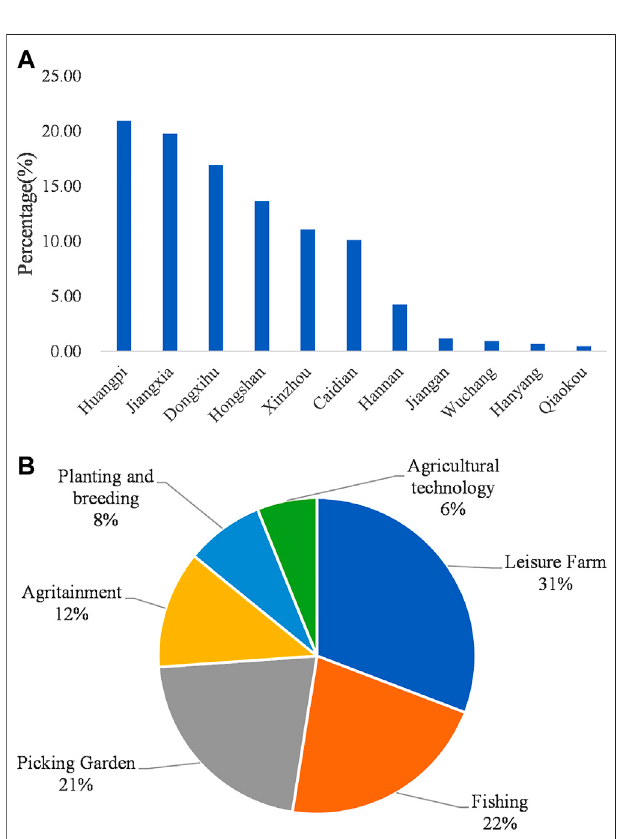
FIGURE 4 | The proportion of leisure agriculture in Wuhan: (A) different regions; (B) different